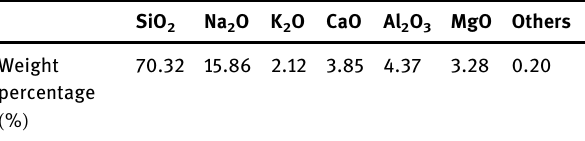
Table 1: The composition of CSG SiO 2